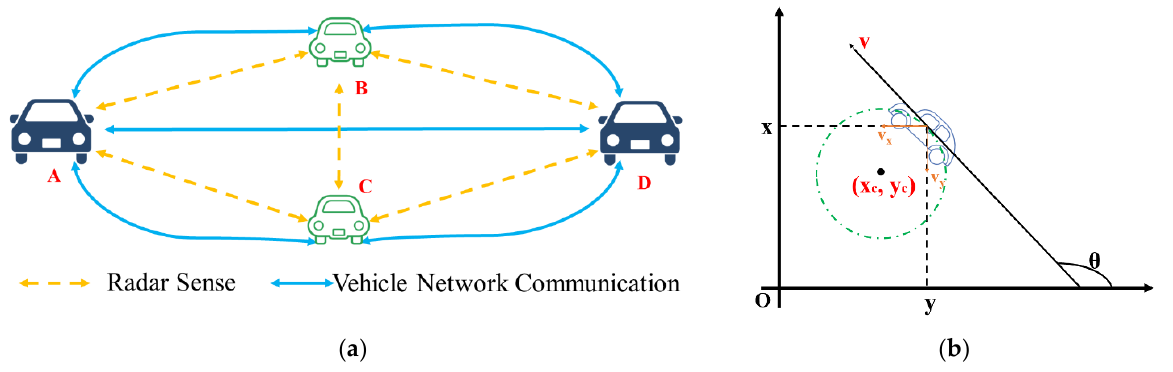
Figure 6. ( a ) Interrelationship between the vehicles; ( b ) Vehicle motion model.